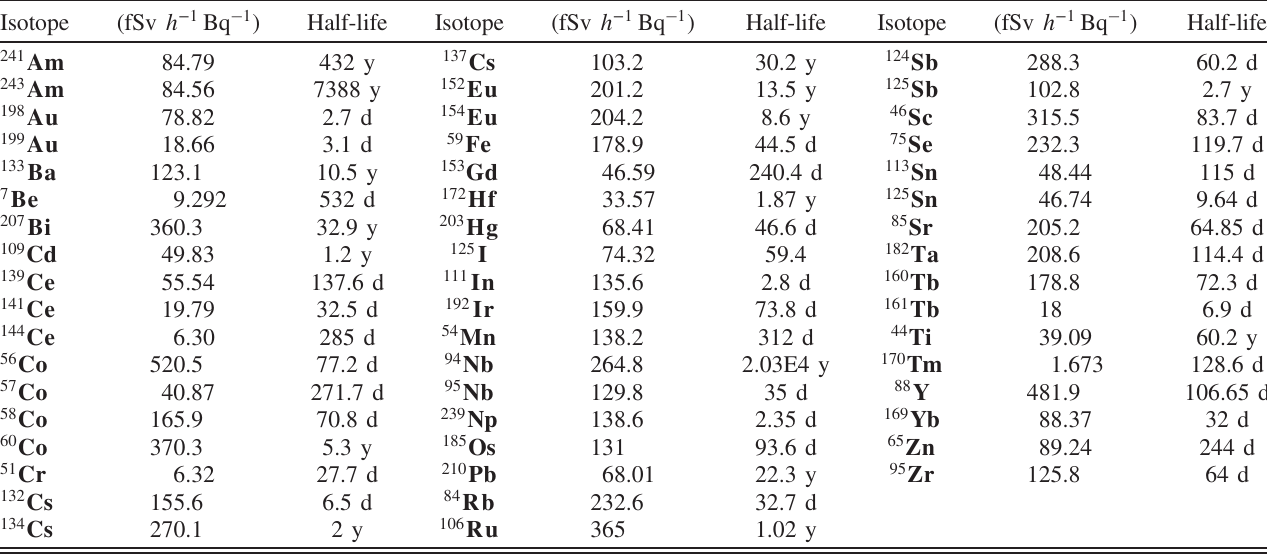
TABLE II. List of radioactive isotopes produced inside the magnets and collimators by spallation reactions that contribute to the induced activity. The dose rates at 1 m are per Bq of the active isotope considering a point source.